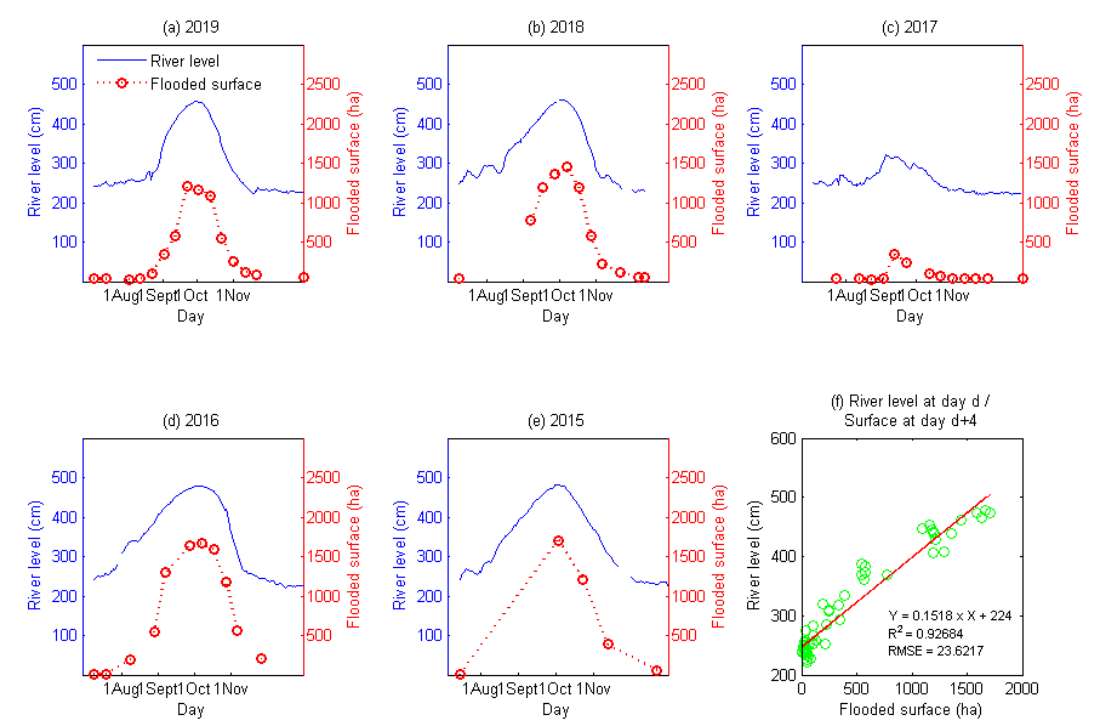
Figure 11. River level (IGN) and flooded surface in the Podor basin from 2015 to 2019 ( a – e ); river level and flooded surface correlation ( f ).